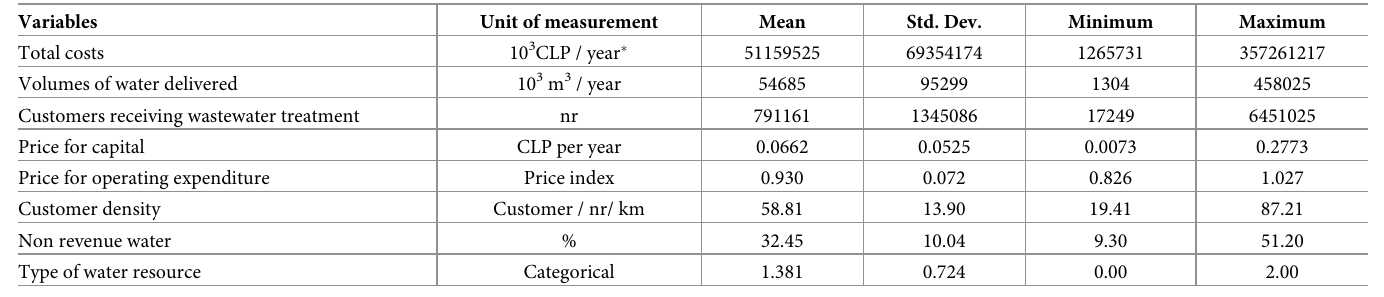
Table 1. Descriptive statistics for the Chilean water and sewerage utilities over the years 2010–2017.